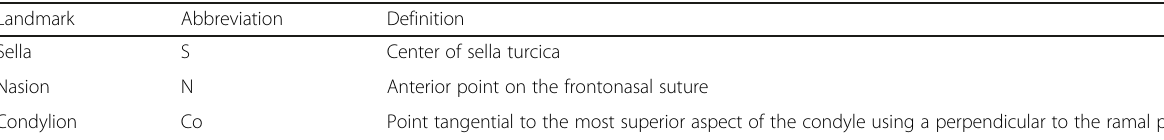
Table 2 Cephalometric landmarks [18] Landmark